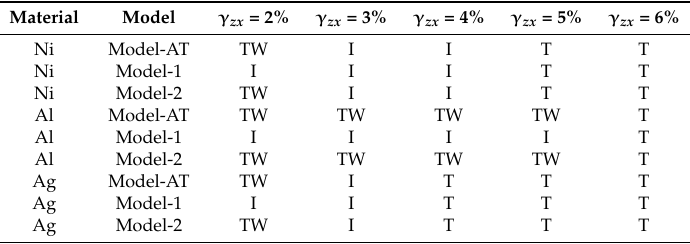
Table 2. Screw dislocation/ESF interaction modes for a variety of materials (Ni, Al, and Ag), models (Model-AT, Model-1, Model-2), and applied shear strains γ zx (2%~6%). Three modes are observed: transformation of an ESF into a three-layer twin (TW), transformation of an ESF into an ISF (I), and transmission of the screw dislocation across the ESF (T), a common sequence for screw dislocation/ESF interactions with an increasing applied shear strain.